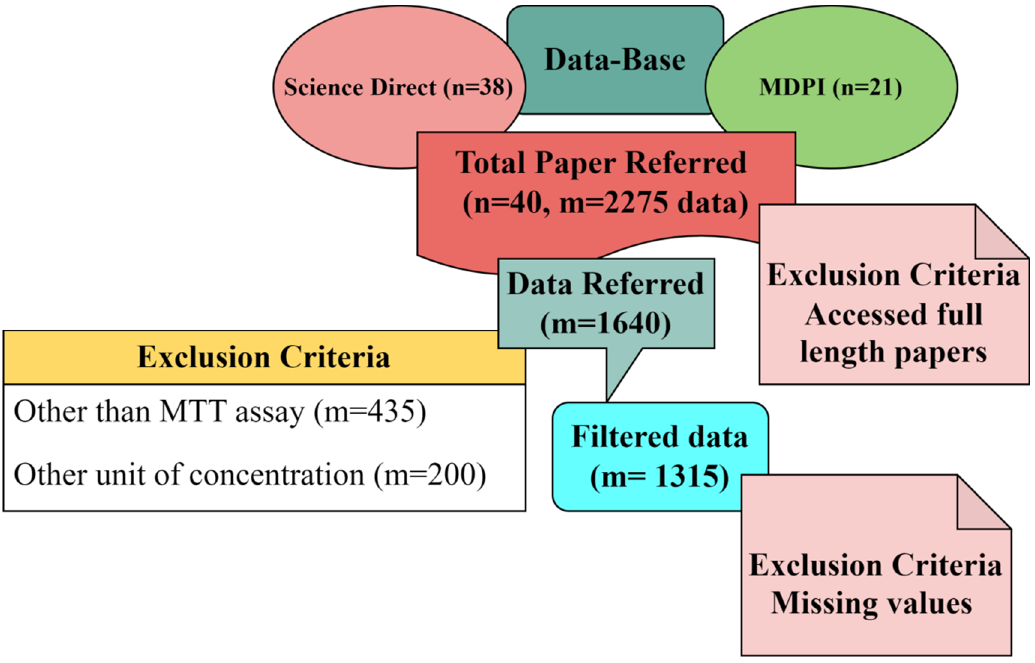
Figure 6. Block diagram representing the selection procedure of research articles.